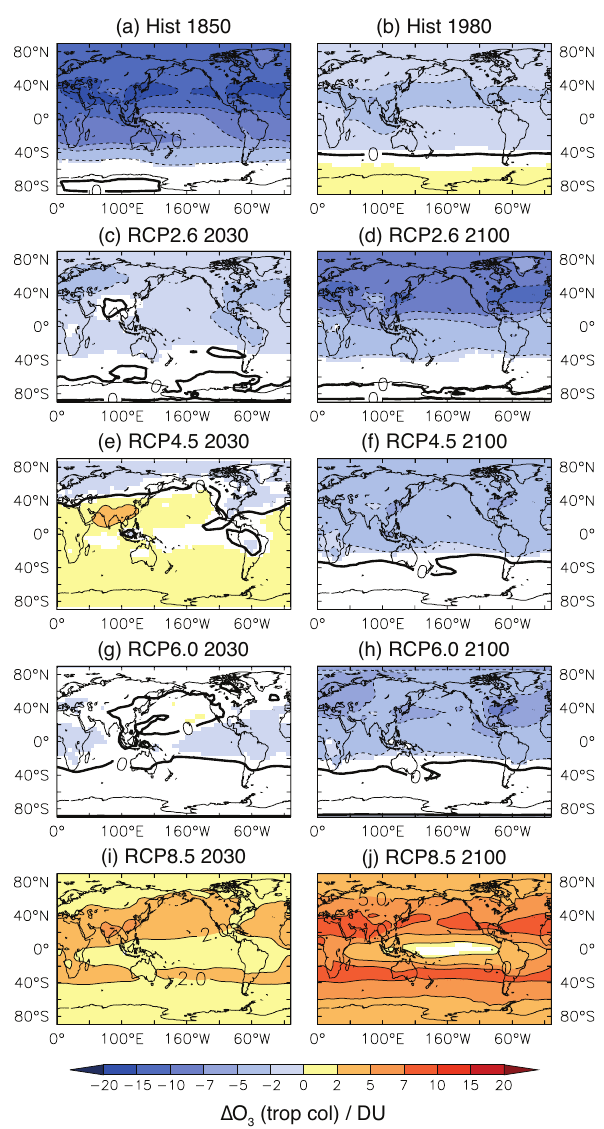
Figure 10 . As Fig. 9, but for the absolute change in the tropospheric ozone column (DU). 2 Fig. 11. As Fig. 9, but for the absolute change in surface ozone